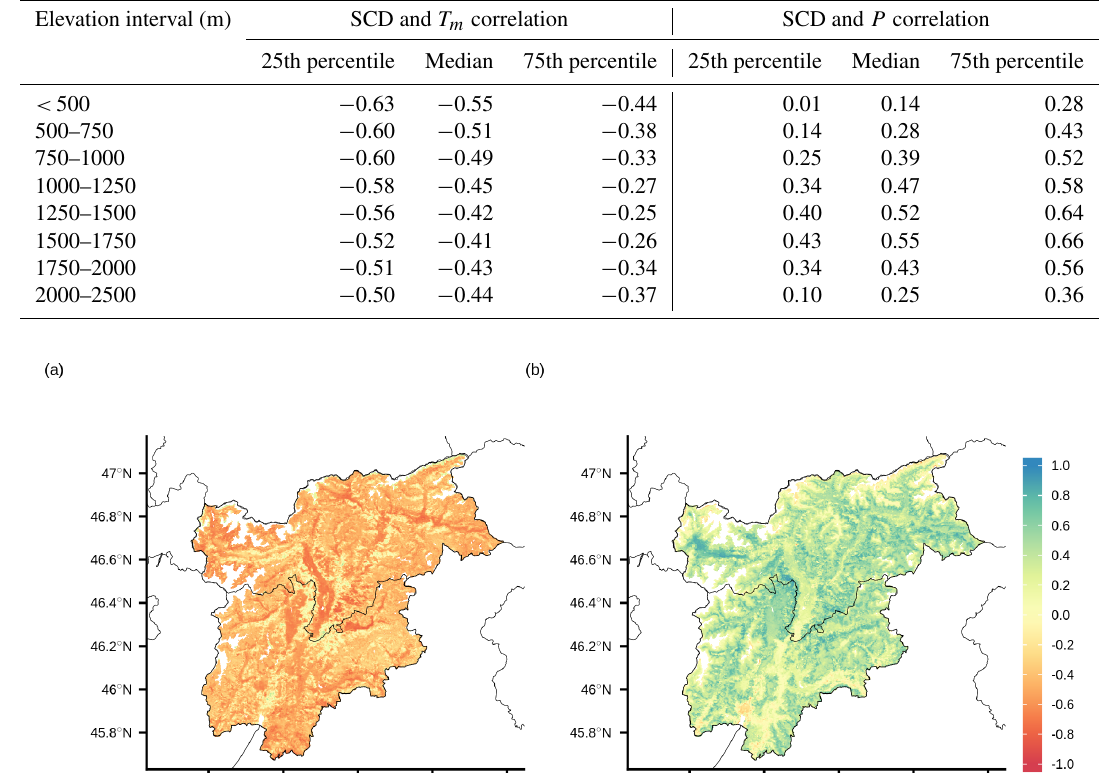
Table 3. Median and inter-quantile range of 2001–2018 correlation coefficients over different elevation bands between SCD (snow-cover duration) and (a) mean temperature and (b) total precipitation in the winter season (December, January and February). Only grid points below 2500m are considered.